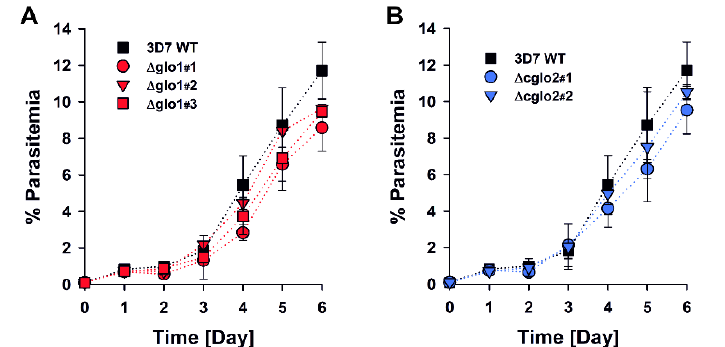
FIGURE 2: Growth curve analysis of P. falciparum knockout strains 3D7Δglo1 and 3D7Δcglo2. (A) Growth curves of three clonal 3D7Δglo1 parasite lines in comparison to wild-type strain 3D7. (B) Growth curves of two clonal 3D7Δcglo2 parasite lines in comparison with wild-type strain 3D7. All strains were diluted to an initial parasitemia of 0.1% and monitored by count- ing parasites in Giemsa-stained blood smears. All data